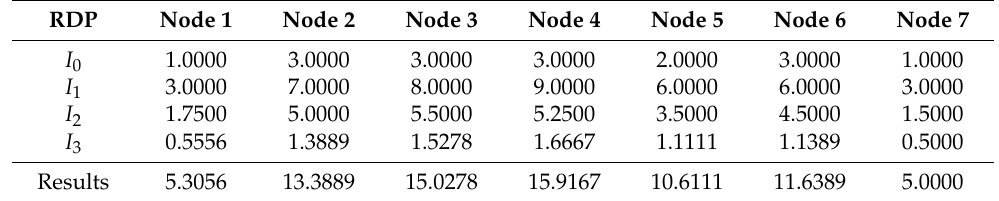
Table 2. The results of RDP ( T = 3) of the example network.